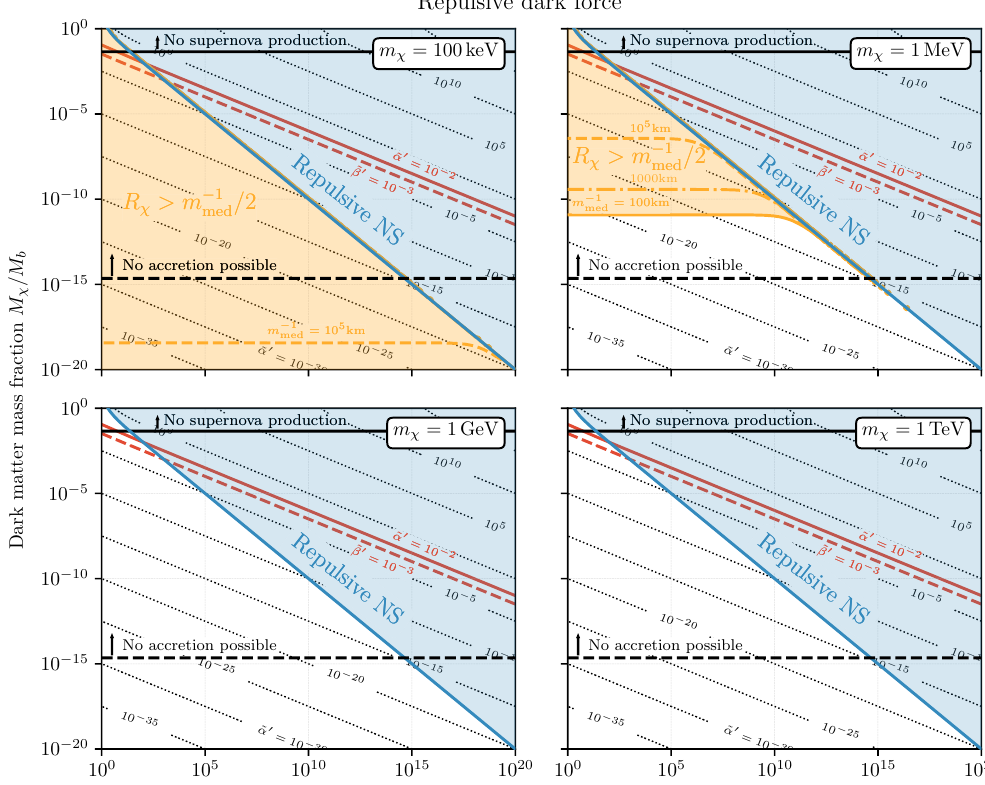
Figure 4 . Constraints on the coupling (cid:11) 0 of a repulsive dark force as a function of the total mass M (cid:31) of dark particles bound to the neutron star. We normalize (cid:11) 0 to the strength of gravity, G N m 2 , and M (cid:31) to the baryonic mass of the neutron star, M b . The four panels correspond to (cid:31) di(cid:11)erent choices of m (cid:31) , as indicated in the plots. The dotted contours show the value of e (cid:11) 0 (in the case of neutron stars with equal dark charge-over-mass ratio) or e (cid:12) 0 (for the case that only one neutron star carries a dark charge, see eq. (2.2)) at each point in the plot. We indicate in red the estimated minimum value of e (cid:11) 0 or e (cid:12) 0 required for the dark force to leave an observable imprint in LIGO data. Regions of parameter space where the neutron star no longer has an overall attractive potential for DM, i.e., N (cid:31) exceeds the bound of eq. (3.4), are shaded in blue. Note that this bound is independent of the DM production or capture mechanism. Bounds shown in black are model-dependent: in the region above the black-dashed line, the DM population inside the neutron cannot be generated by capture from the halo, based on the geometric arguments that lead to eq. (3.12). Above the black solid line, the hypothesis that the DM population is produced during the supernova that created the neutron star is not tenable because the energy available in a supernova (as measured in SN 1987A) is not su(cid:14)cient. Inside the yellow shaded region, the dark core has a radius larger than the range of new Yukawa force, R (cid:31) (cid:21) m (cid:0) 1 = 2. The solid, dot-dashed, med and dashed yellow lines correspond to m (cid:0) 1 = f 100 km ; 1000 km ; 1 (cid:2) 10 5 km g , respectively. Within med the yellow regions, the DM particles would be stripped away from their host neutron star before they can have a signi(cid:12)cant impact on the inspiral. The neutron star parameters are chosen in accordance with table 1, and we normalize (cid:11) 0 such that q (cid:31) =